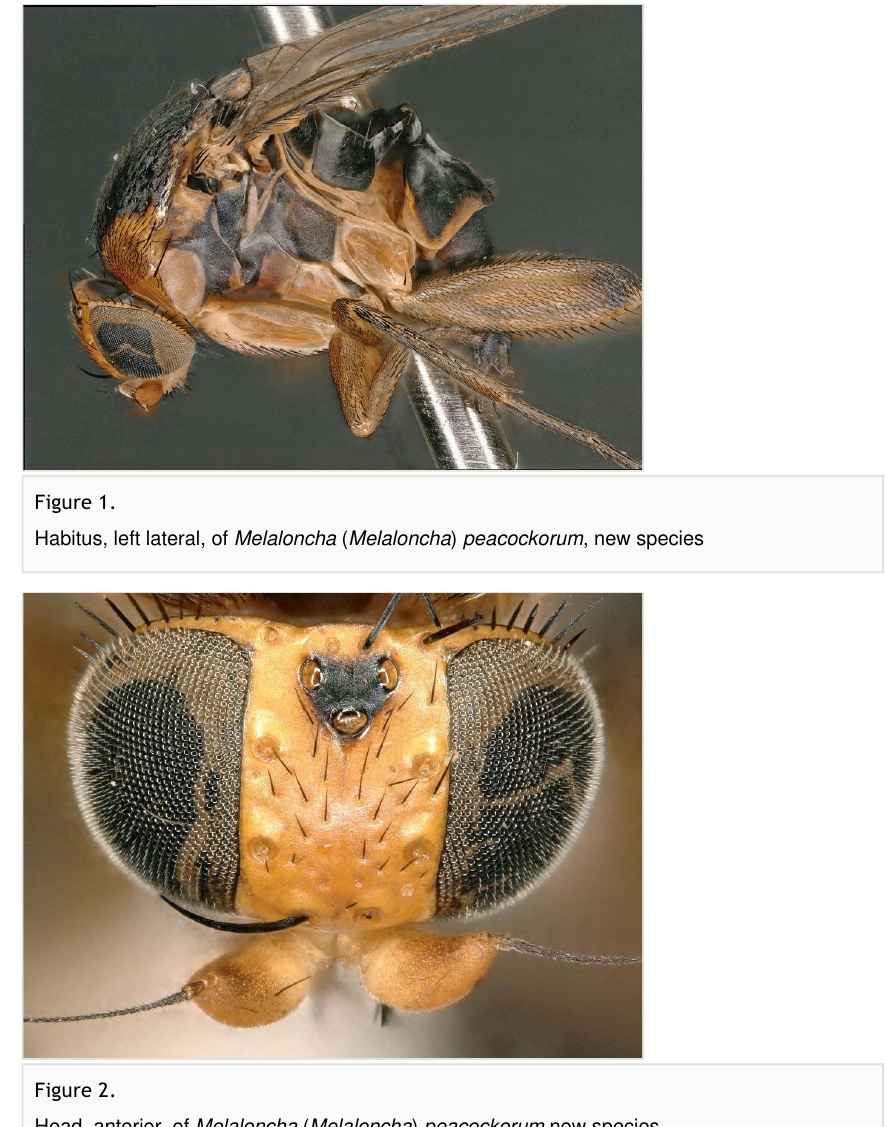
irregular dorsal bare area. Foretarsomeres unmodified. Posterior claw of foreleg not enlarged, claws lobed at base. Costa 0.52 wing length. Wing vein R2+3 absent. Halter yellow. Abdominal tergites black with silvery iridescence. Venter of abdomen yellow. Oviscape black, setose, with rounded, shorter dorsal lobe and longer ventral lobe ending in pair of divergent processes.